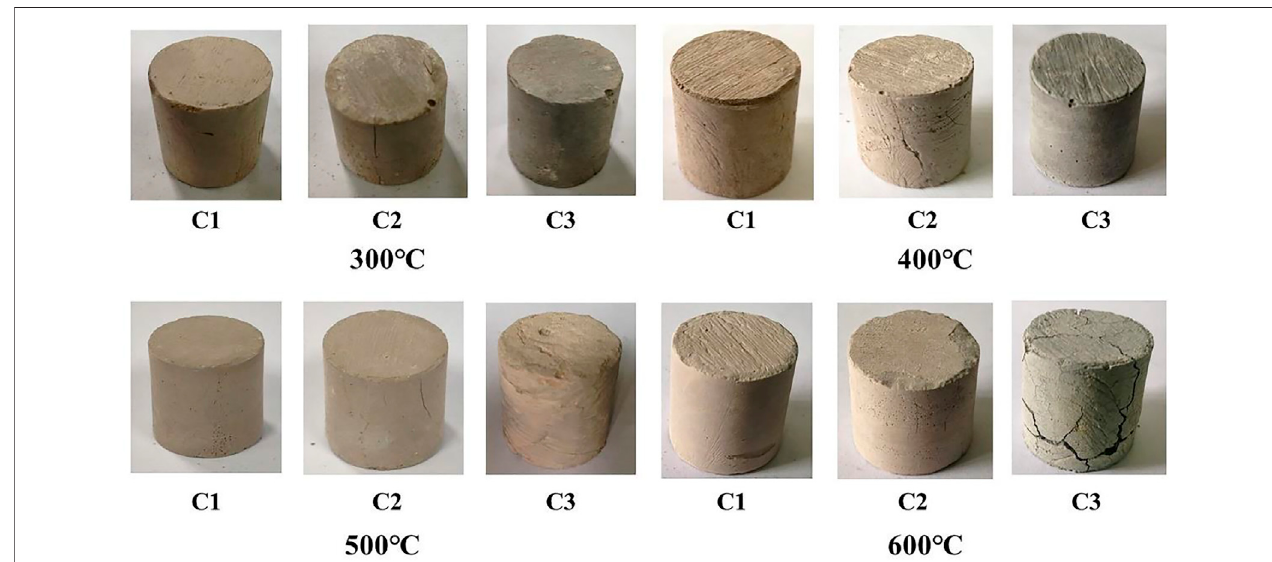
FIGURE 11 | Macro morphology of cement paste cured at different high